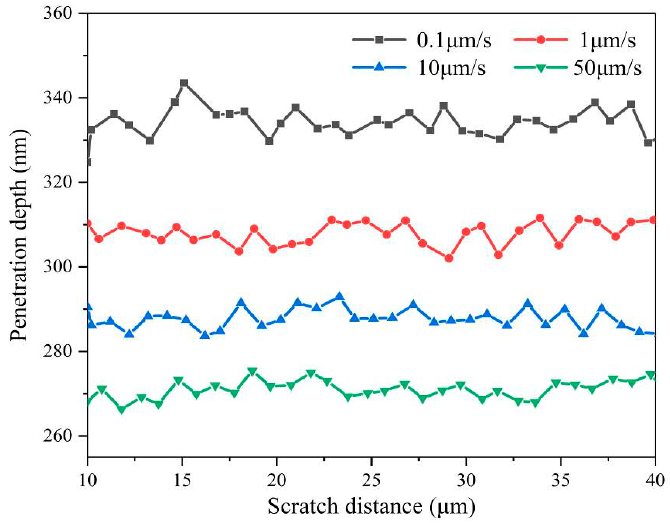
Figure 8. The penetration depth of the indenter at different scratch speeds.